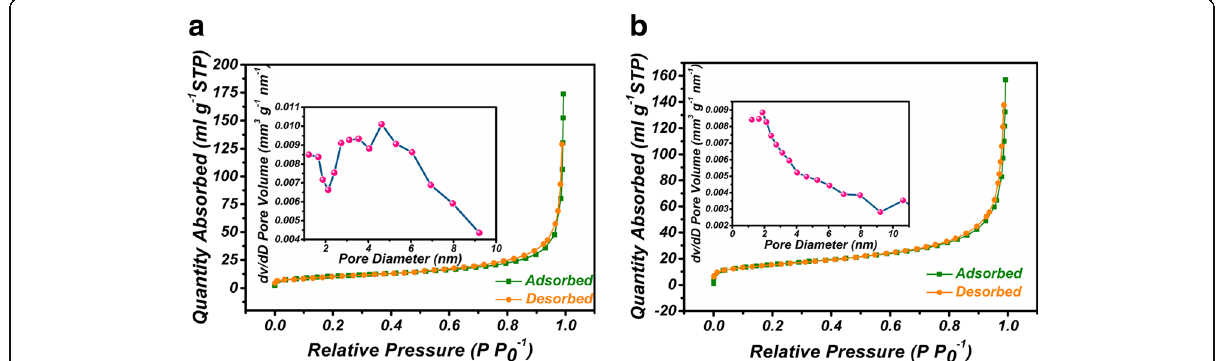
Fig. 4 BET measurements of a Ni(OH) 2 NCs and (b) Ni(OH) 2 BNCs. Insets of a and b are the corresponding pore size distributions of Ni(OH) 2 NCs and